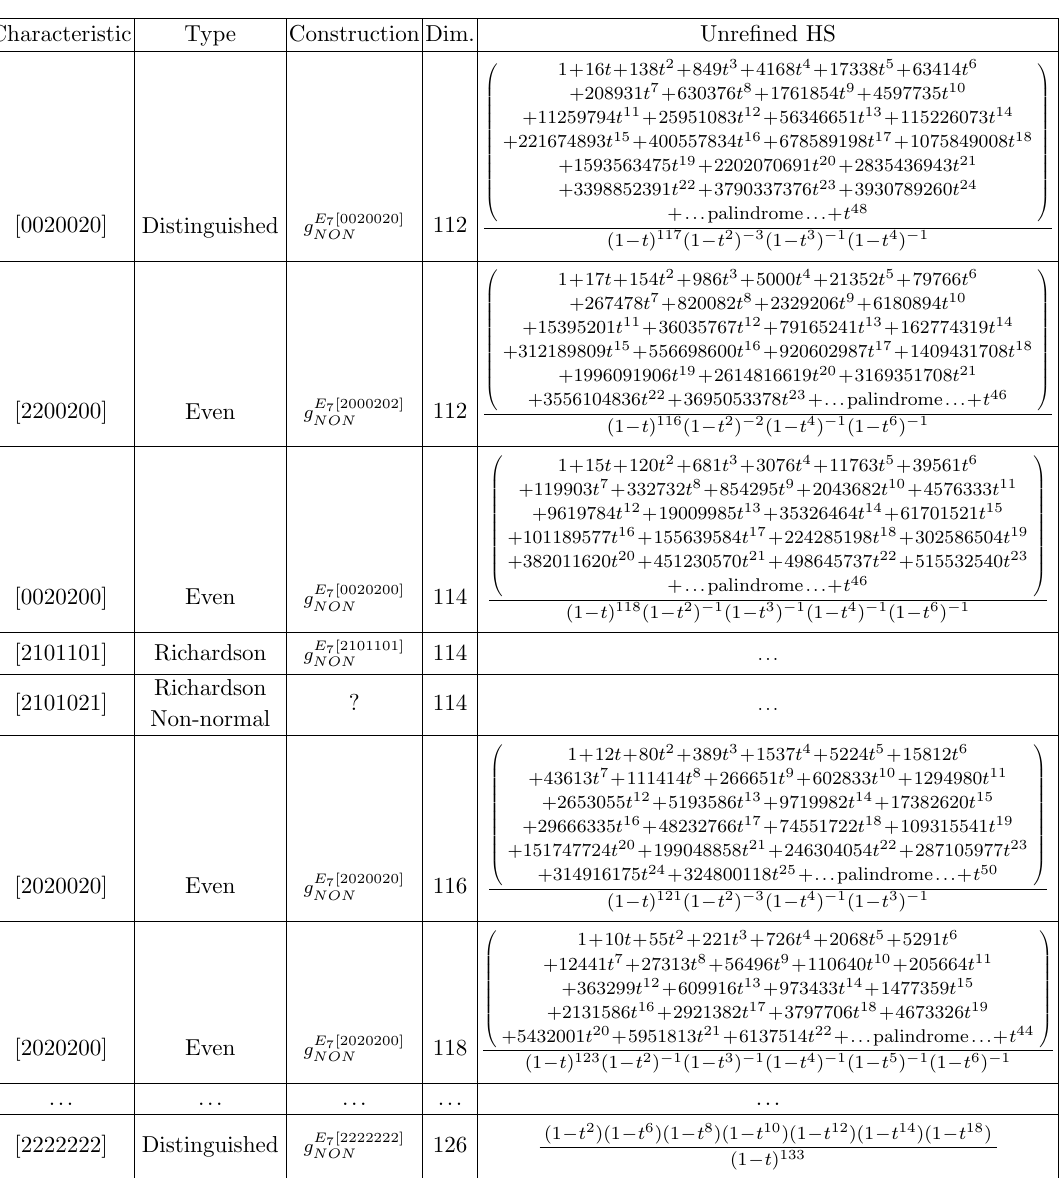
Table 23 . E 7 orbit constructions and Hilbert series (F). Some orbits in the upper Hasse diagram remain to be